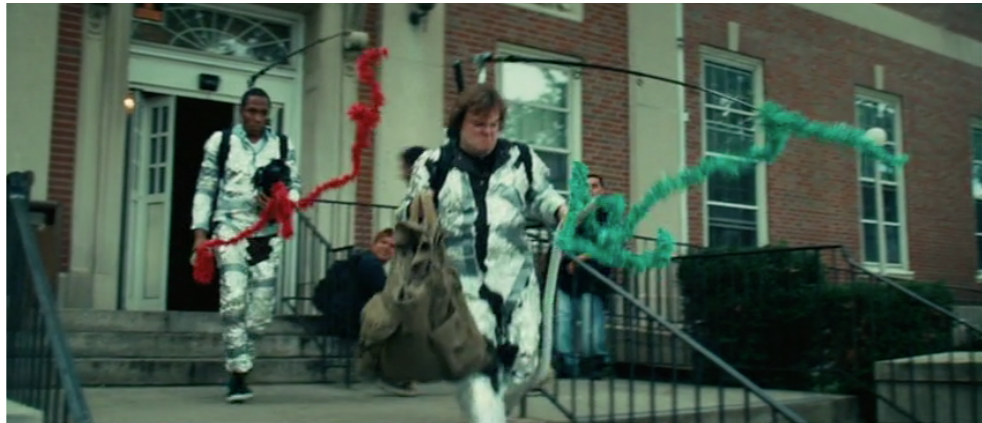
Figure 3. Mike (Mos Def) and Jerry (Jack Black) bust ghosts at the local public library.